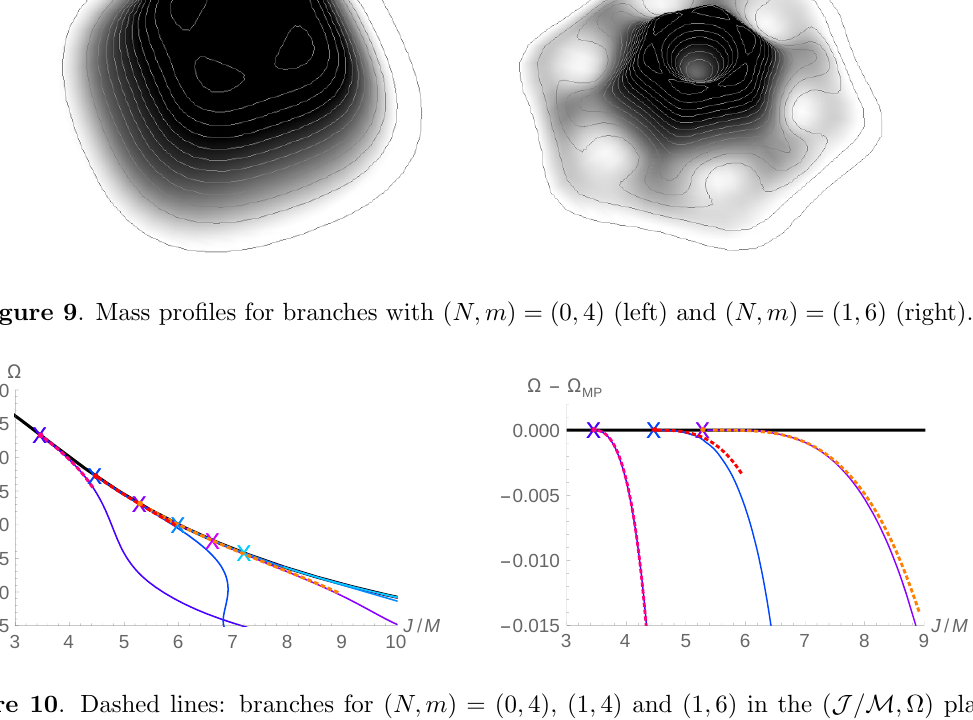
Figure 10 . Dashed lines: branches for ( N; m ) = (0 ; 4), (1 ; 4) and (1 ; 6) in the ( J = M ; (cid:10)) plane. Solid lines: branches of axisymmetric solutions. It can be observed that black (cid:13)ower curves take a similar path to the ripple branches originating from the same zero